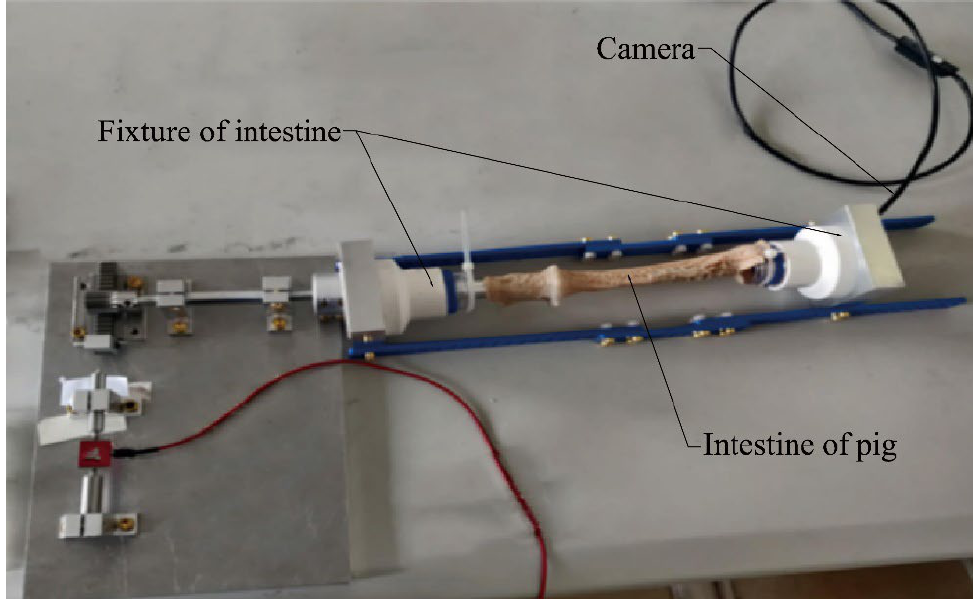
Figure 7. Use of the fixture of intestine.